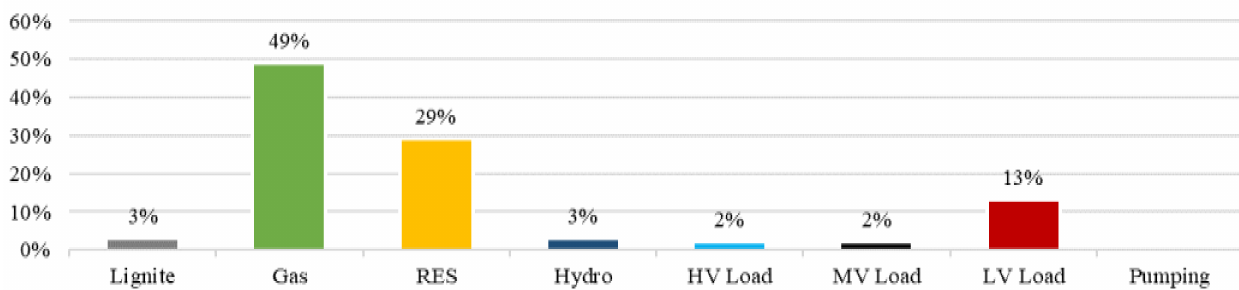
Figure 8. Intraday Volume—Sell Volume mix (%), (May 2021), Source: Hellenic Energy Exchange and Authors’